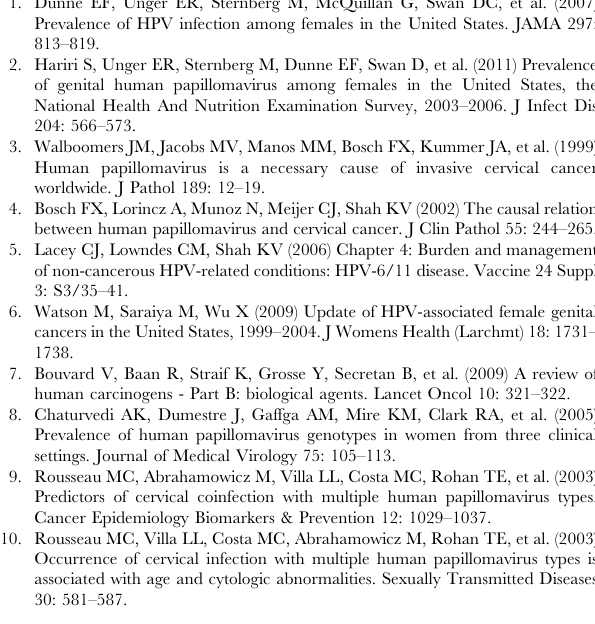
colposcopy population ( C ).